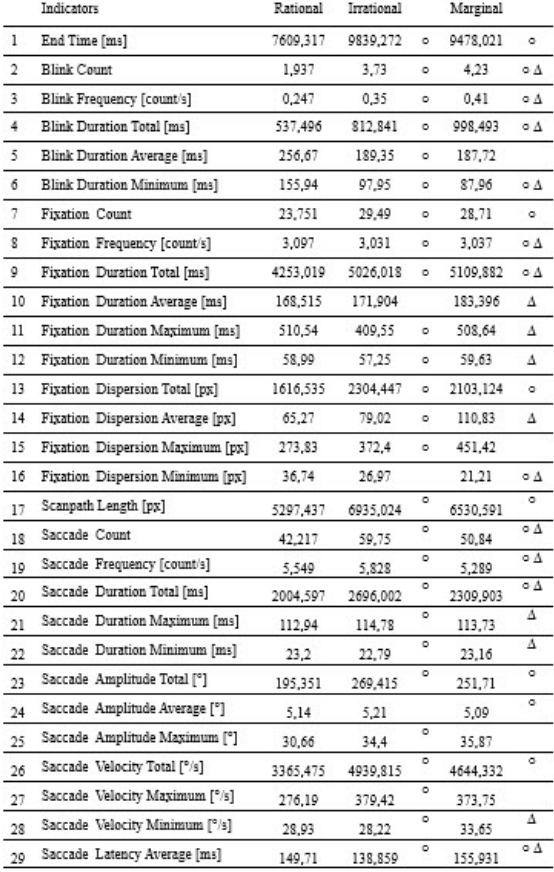
Table 4. The oculomotor activity indi- cators of the respondents with different level of rationality (making financial decision with probability 0.01 and